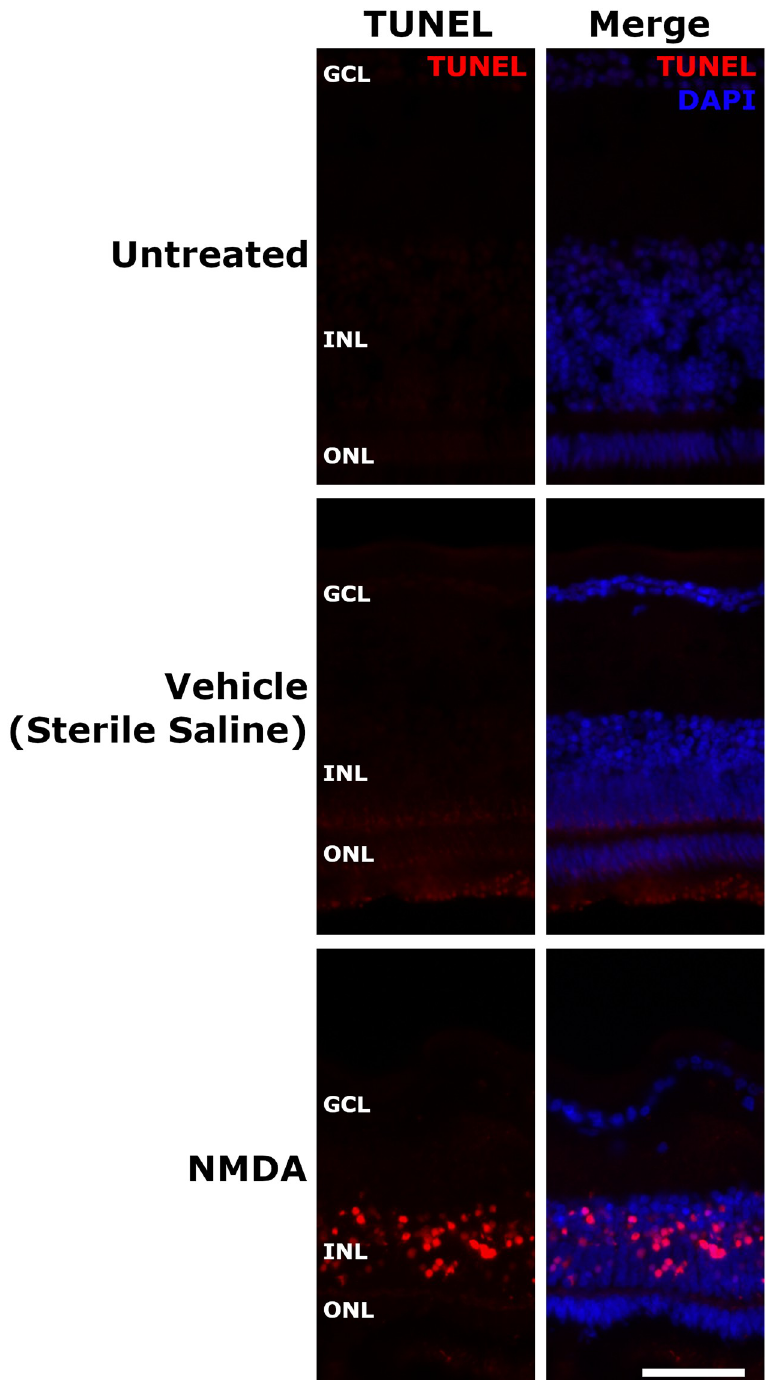
Fig 3. NMDA induced TUNEL response in chick retina. Untreated, vehicle (sterile saline), and NMDA injected chicks at D1 post injection. Both untreated and vehicle-injected chicks displayed no TUNEL-positive cells. NMDA- treated chicks saw a large number of TUNEL-positive cells in the INL, but not other retinal layers. The scale bar denotes 50 μ m. Abbreviation: GCL—ganglion cell layer, INL—inner nuclear layer, ONL—outer nuclear layer.